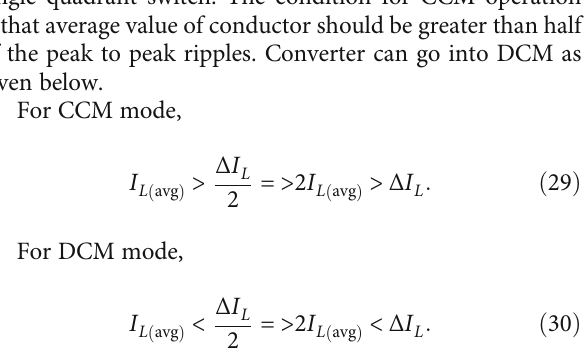
Figure 9: Steady